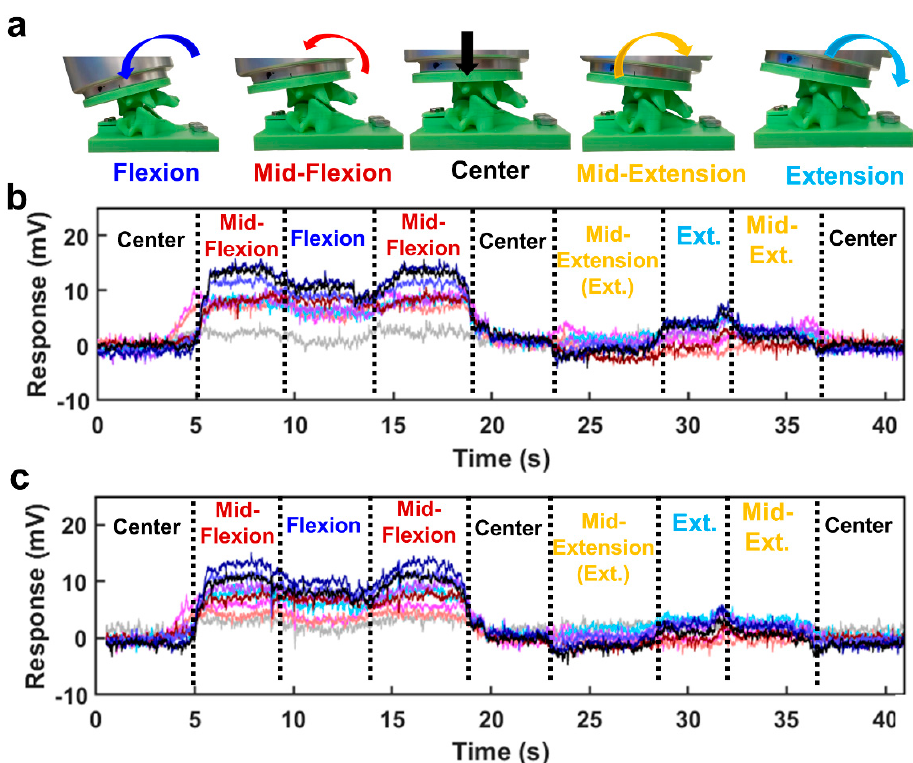
Figure 5. Human spine robotic replica posture measurement via intervertebral monitoring. ( a ) Five robotically actuated postures of the artificial disc-implanted spine replica were classified by four machine learning algorithms during flexion and extension motions. ( b ) Taxel responses measured with the 10% ferrofluid soft magnet. ( c ) Taxel responses measured with the 15% ferrofluid soft magnet.